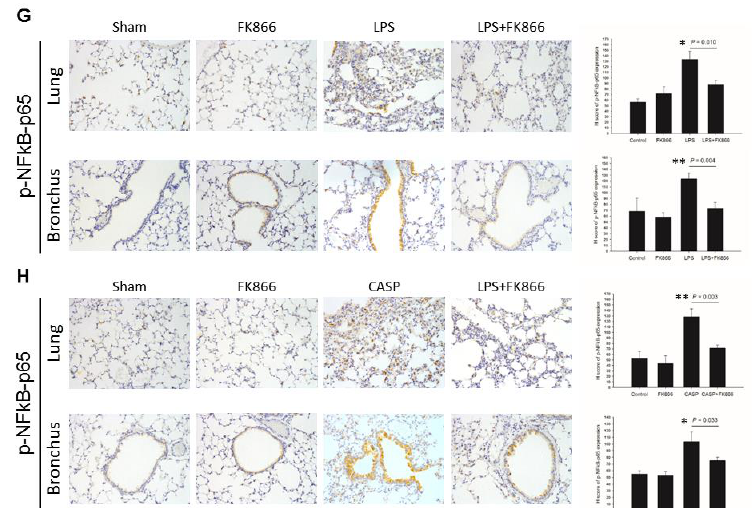
Figure 3. LPS and CASP treatment in mice enhanced visfatin expression in circulation and in lung tissues. ( A , B ) Serum visfatin levels in sham mice and LPS- and CASP-treated mice. ( C , D ) Visfatin, ( E , F ) p-STAT3(Y705), and ( G , H ) p-NF- κ B-p65 expression in lung tissues in sham mice and LPS- and CASP-treated mice, determined by immunohistochemistry. The representative results are from three separate experiments. Results are mean ± SD ( n = 3). *, p value < 0.05. **, p value < 0.01. (100× amplification).